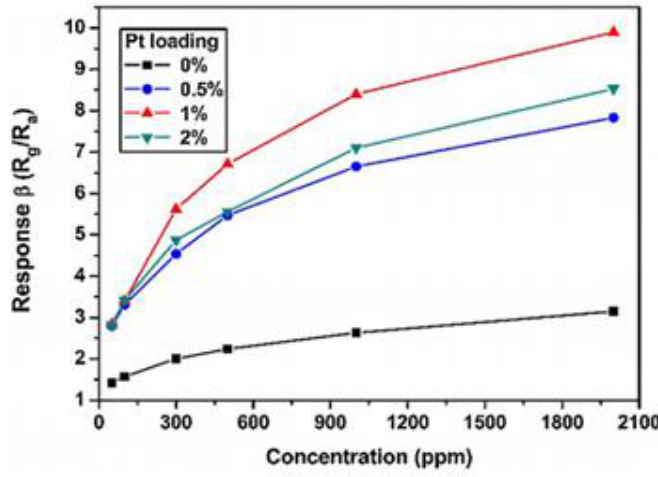
Figure 8. Gas responses of different Pt doping NiO based sensors to various concentrations of for- maldehyde at optimal operating temperature of 200 °C [64].